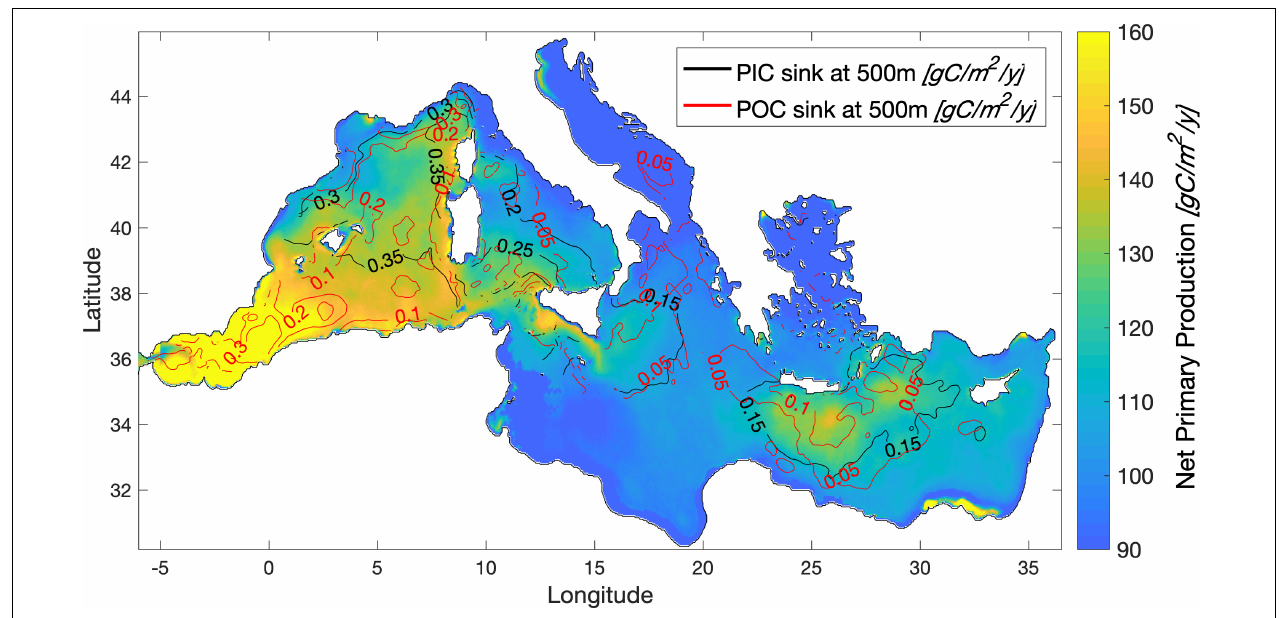
FIGURE 3 | Map of the net primary production vertically integrated and contour of the sink fluxes at 500 m depth of POC (red contour) and PIC (black